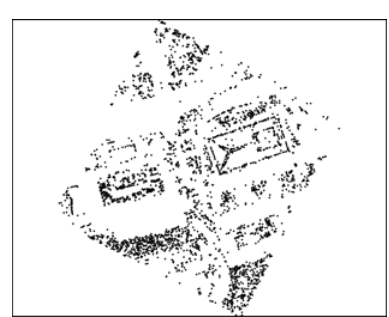
Figure 5. Grid cells of initial matching results